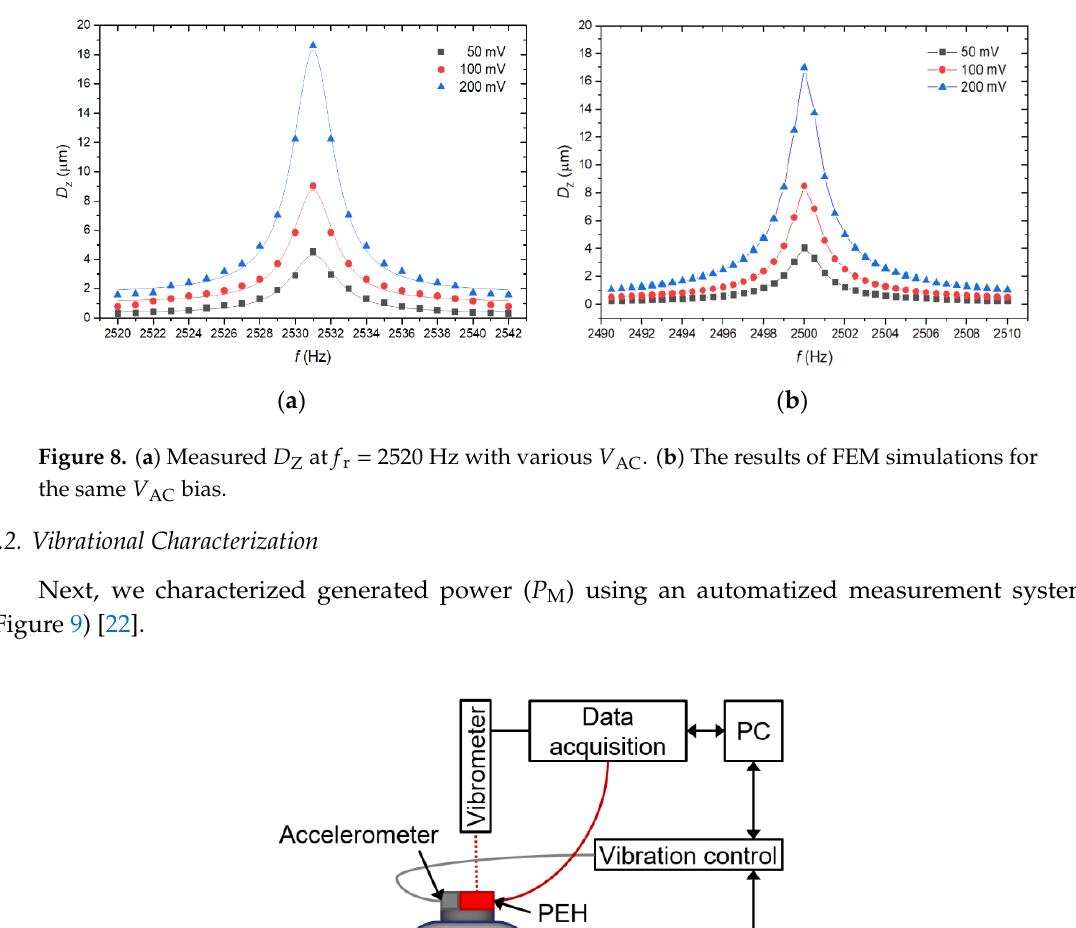
Figure 9. Measurement setup, based on vibration excitation of PEH for determination of P M .